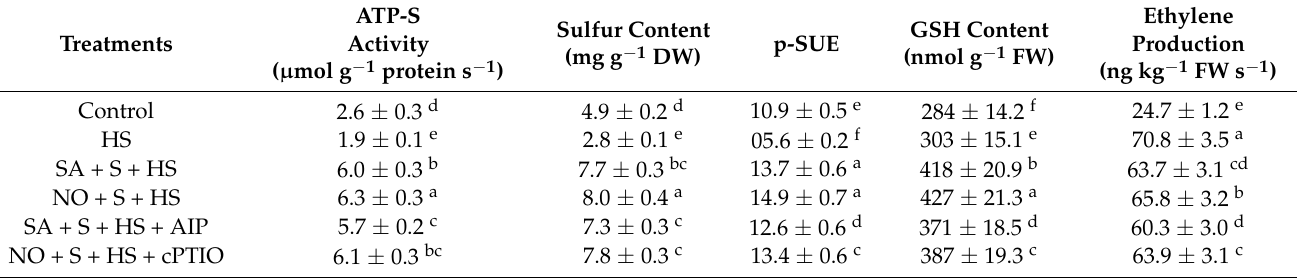
Table 5. Activity of ATP-sulfurylase (ATP-S), sulfur content, photosynthetic sulfur use efficiency (p-SUE), reduced glutathione (GSH) content and ethylene production of wheat ( Triticum aestivum L.) cv. HD-3226 treated with 0.5 mM salicylic acid (SA) or 50.0 µ M nitric oxide (NO) together with 2.0 mM SO 4 − 2 and/or 0.5 mM AIP and/or 100 µ M cPTIO in presence or absence of heat stress (HS) at 30 days after